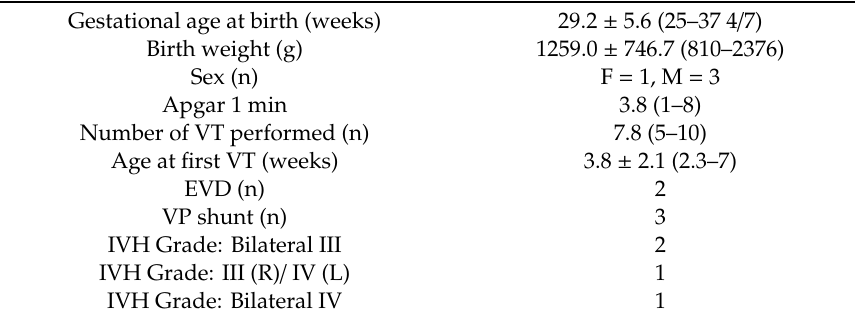
Table 1. Clinical parameters for post-hemorrhagic ventricular dilatation (PHDV) patients.